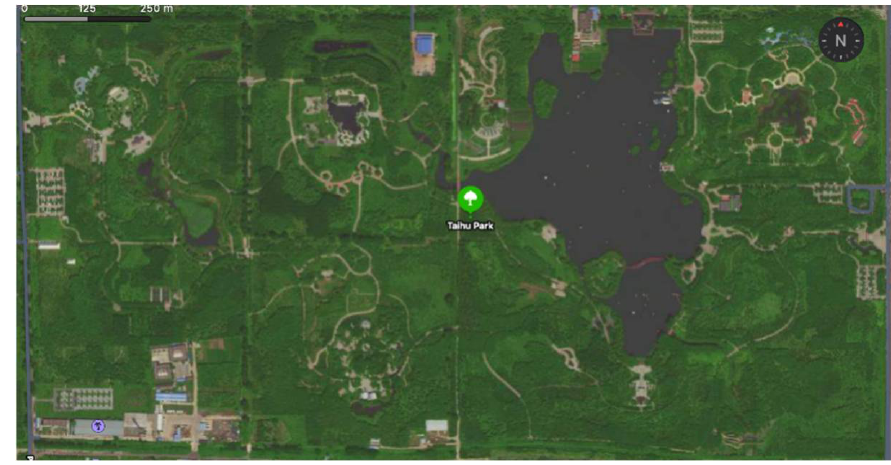
Figure 3. Map of Taihu